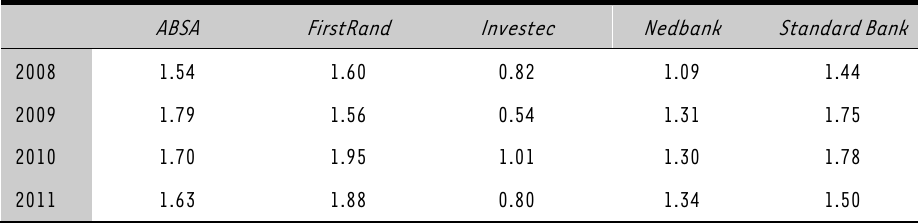
TABLE 11: Yearly Price-to-book value ABSA FirstRand Investec